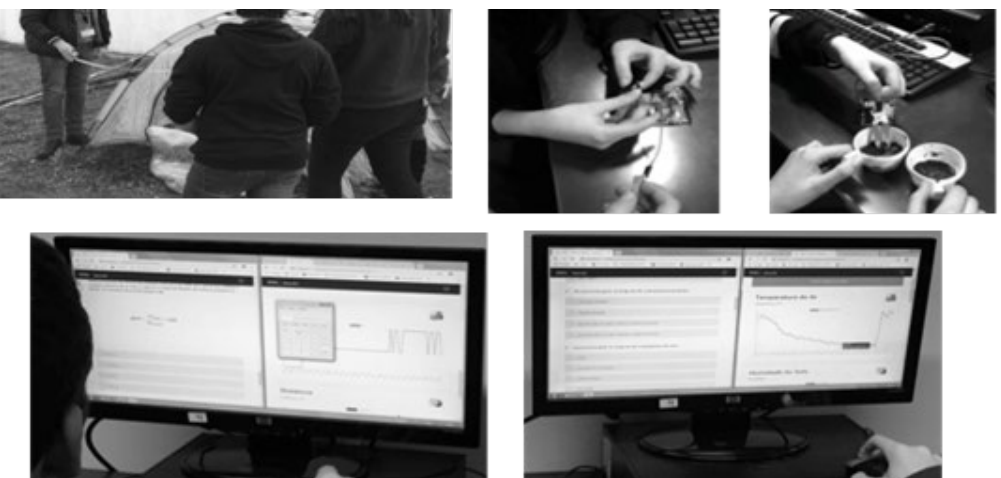
Figure 5. Photographs of activities with